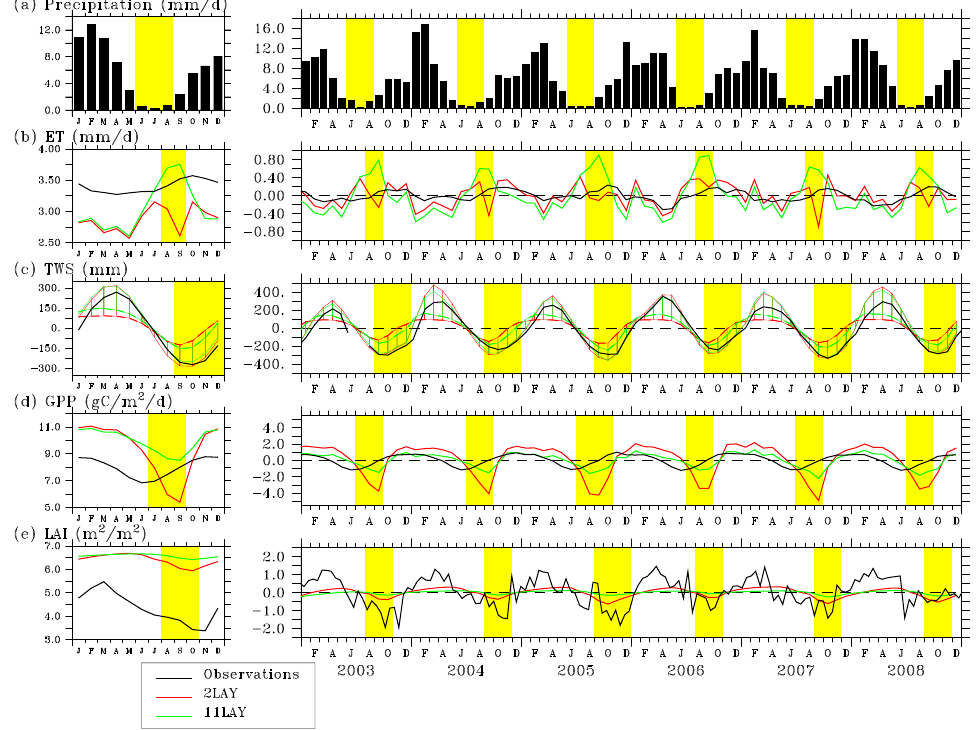
Figure 7. Seasonal cycle (left panels) and interannual monthly variation of anomaly (except precipitation) (right panels) in (a) precipitation (mmd − 1 ), (b) ET (mmd − 1 ), (c) TWS change (mm) (d) GPP (gCm − 2 d − 1 ) and (e) LAI (m 2 m − 2 ) averaged over the Xingu sub-basin, from simulations (2LAY and 11LAY) and observations, for the period 2003–2008. For anomaly computation, the mean value over the period considered was subtracted from each monthly value of the variable. The yellow band indicates the dry season (in a ) and the period during which the difference in results between the 2LAY and 11LAY is high (in b to e ). The shaded area (red and green in c ) corresponds to the simulated anomaly of water stored in reservoirs other than the soil reservoir (dotted red and green lines in c